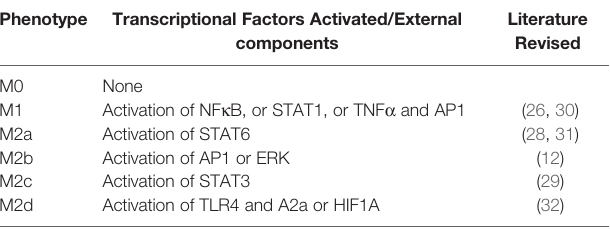
TABLE 1 | Macrophage phenotypes used to name each attractor.